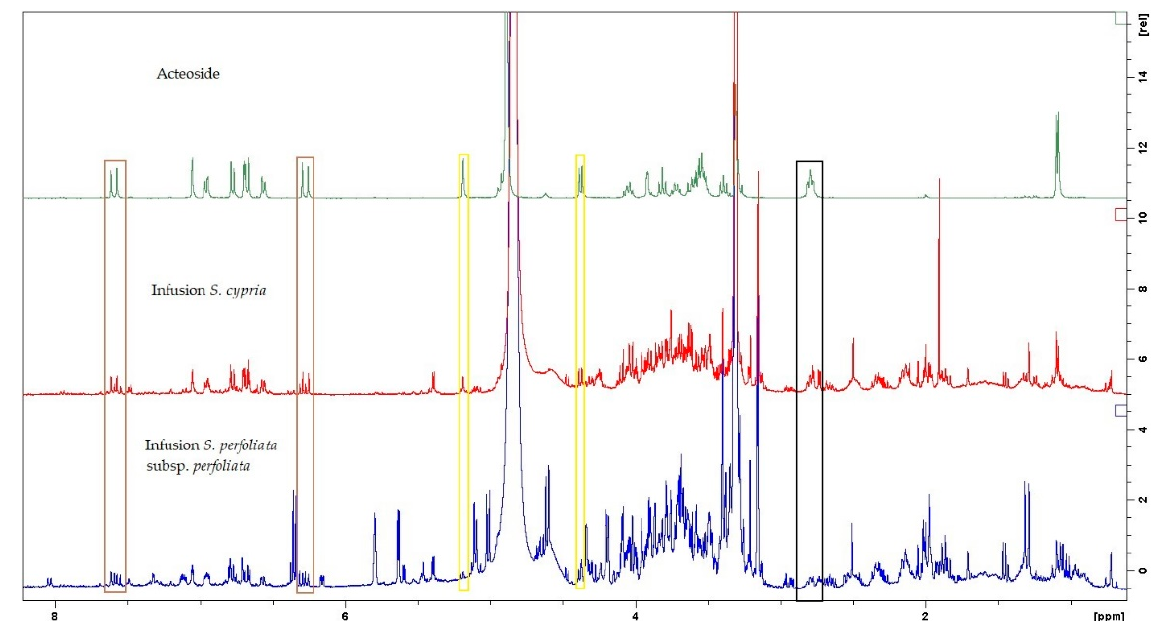
Figure 6. The overlaid 1 H-NMR spectra of the infusions of S. cypria and S. perfoliata subsp. perfoliata and of acteoside. The signal in the black box refers to the methylene hydrogens of the phenylethyl group. The signals in the brown boxes refer to the hydrogens of the trans bond (d, 16.0 Hz) of the caffeoyl group, whereas the signals in the yellow boxes show the anomeric hydrogens of acteoside.